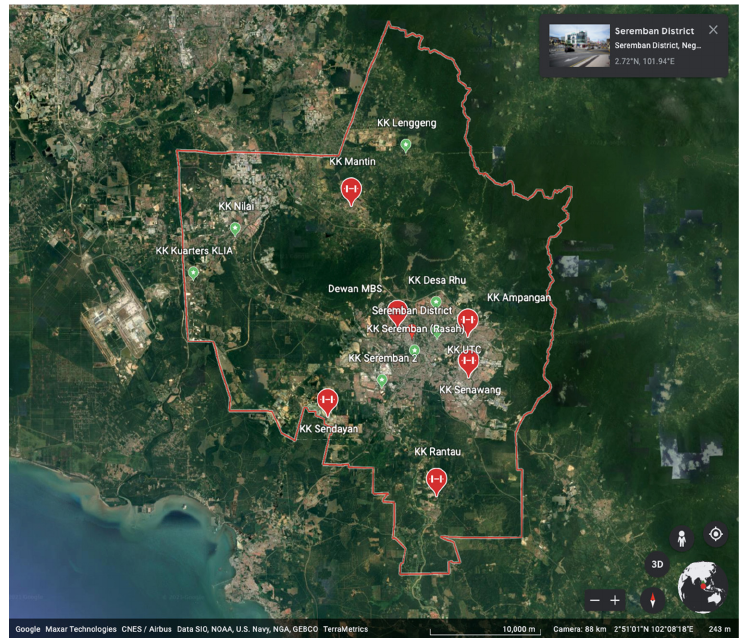
Figure 2. Mapping of study location based on cluster of health facilities.